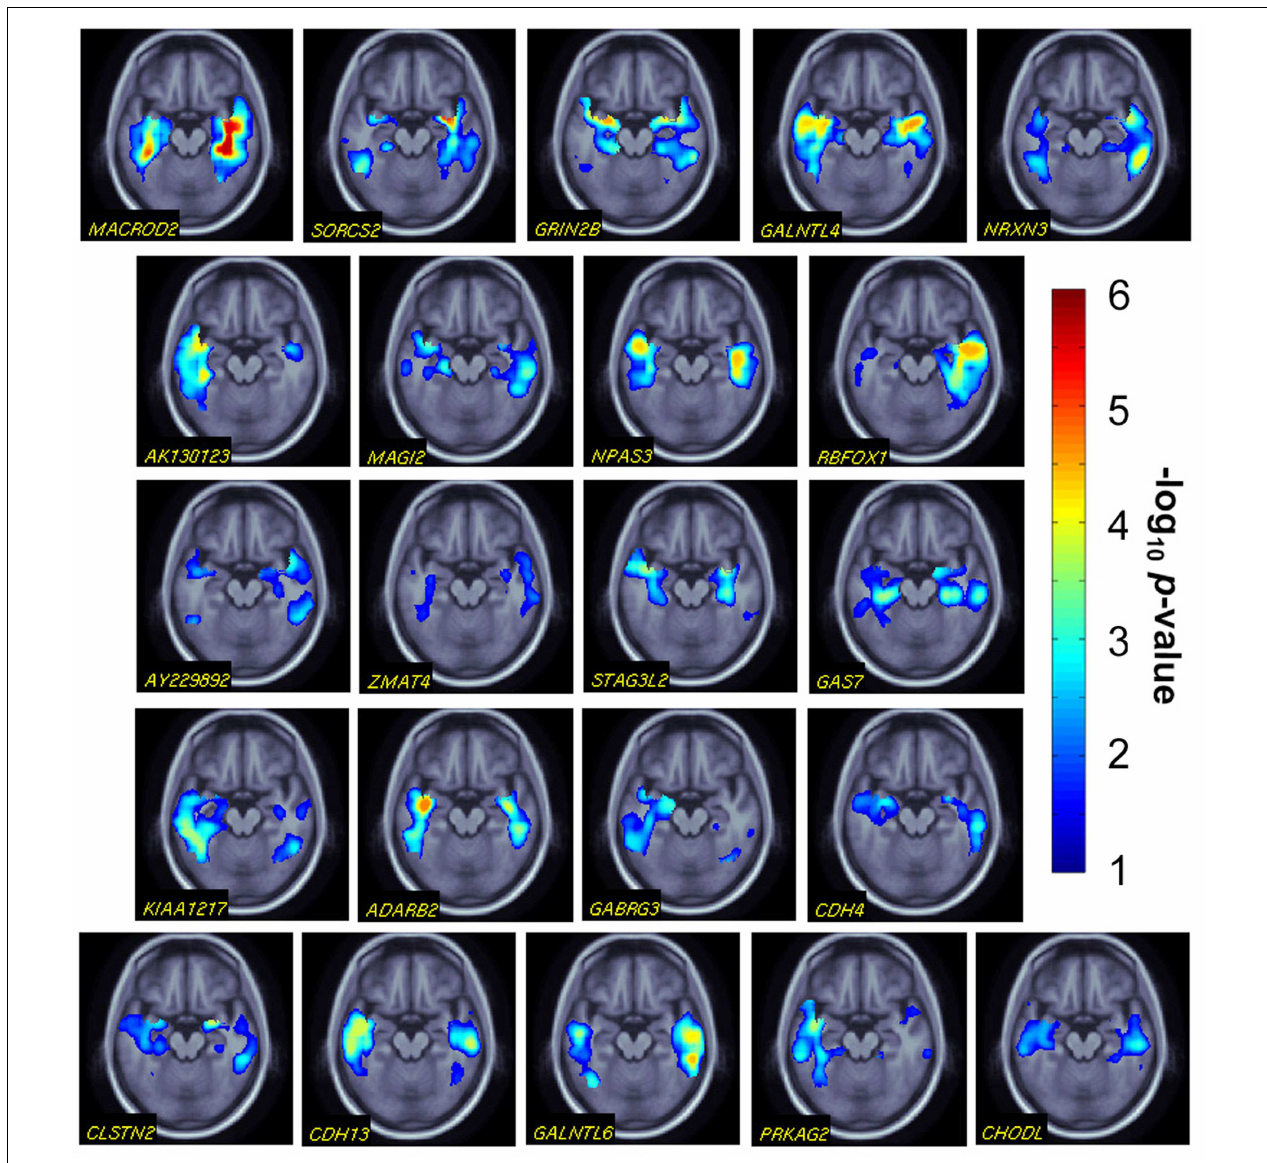
represent more significant effects (i.e., higher effect sizes in the analysis of overall temporal lobe volume). p -values are corrected for multiple comparisons within the 3D image search region, using a regional false discovery rate